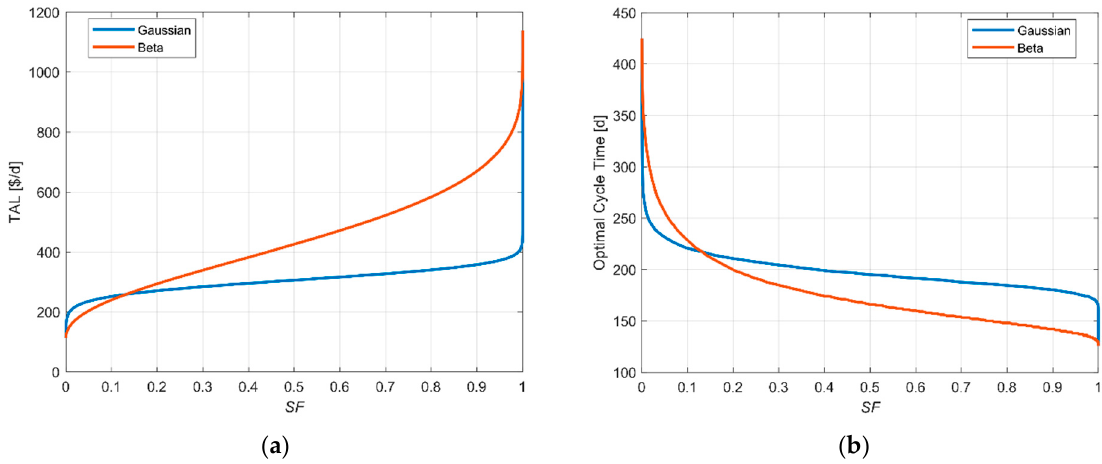
Figure 9. Flexibility analysis results—mechanical cleaning: ( a ) Optimal cycle TAL vs. SF ; ( b ) Optimal cycle time vs. SF